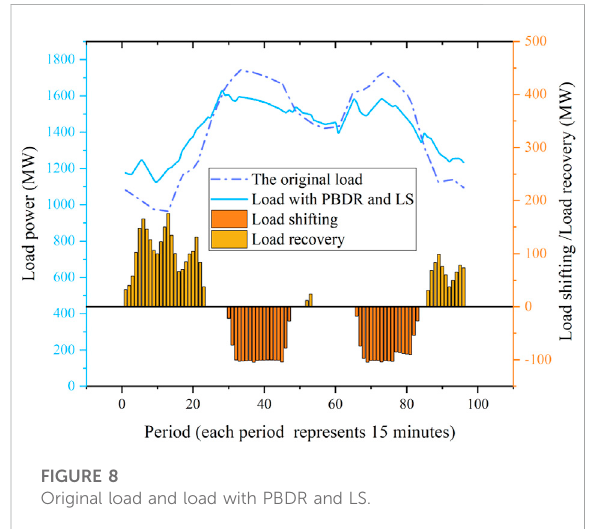
FIGURE 8 Original load and load with PBDR and LS.